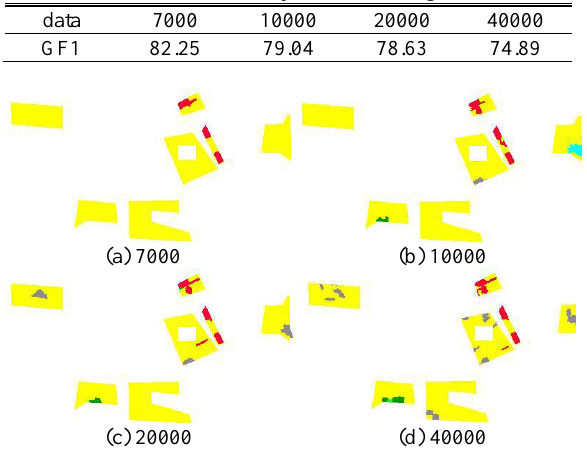
Fig.11 Classification maps of different segmentation